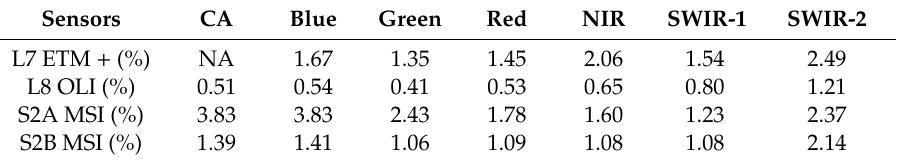
Table 14. Niger 2 random error (precision) between measured and simulated values.